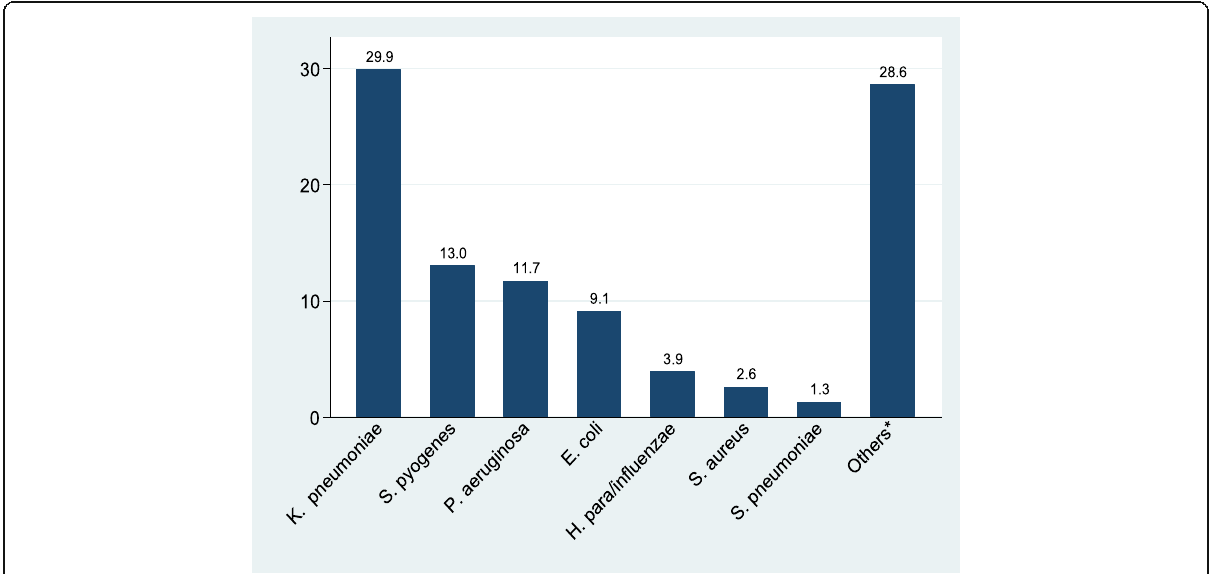
Fig. 2 Bacterial isolates from 72 patients with positive sputum culture